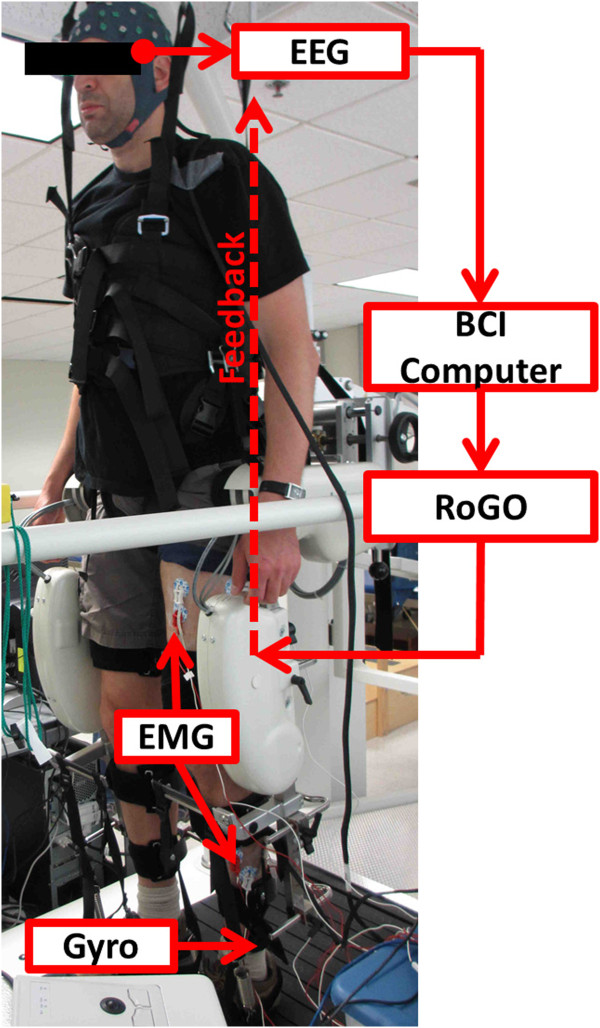
Experimental setup. The experimental setup showing a subject suspended in the RoGO, while donning an EEG cap, surface EMG electrodes, and a gyroscope on the left leg. A monitor (not shown), placed in front of the subject at eye-level, presented instructional cues.